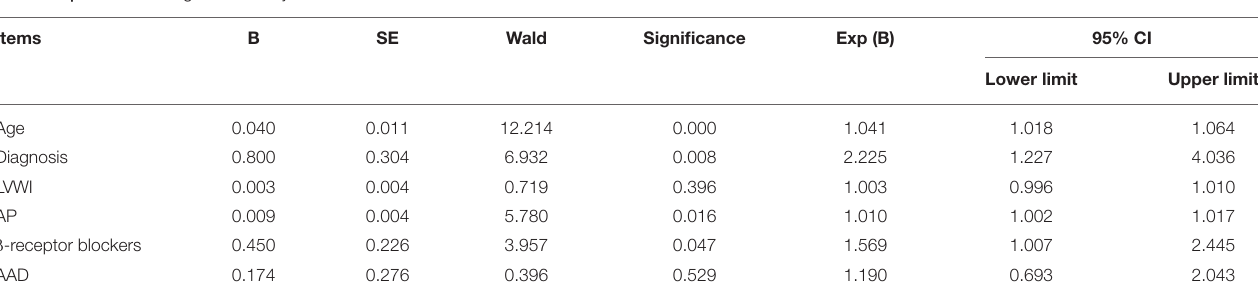
TABLE 8 | Multivariate regression analysis of